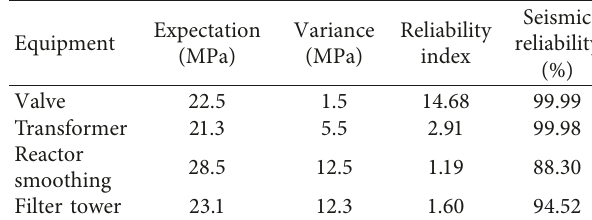
Table 2: Seismic reliability of important electrical equipment.